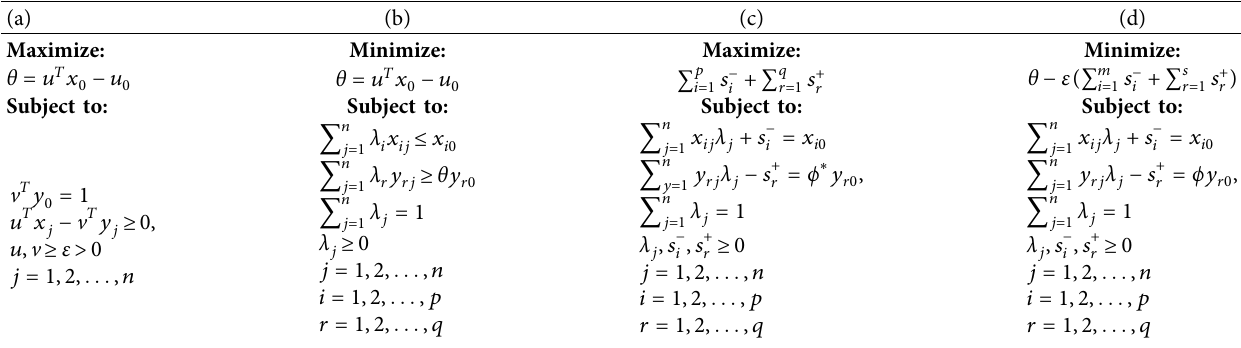
Table 4: Output-oriented BCC